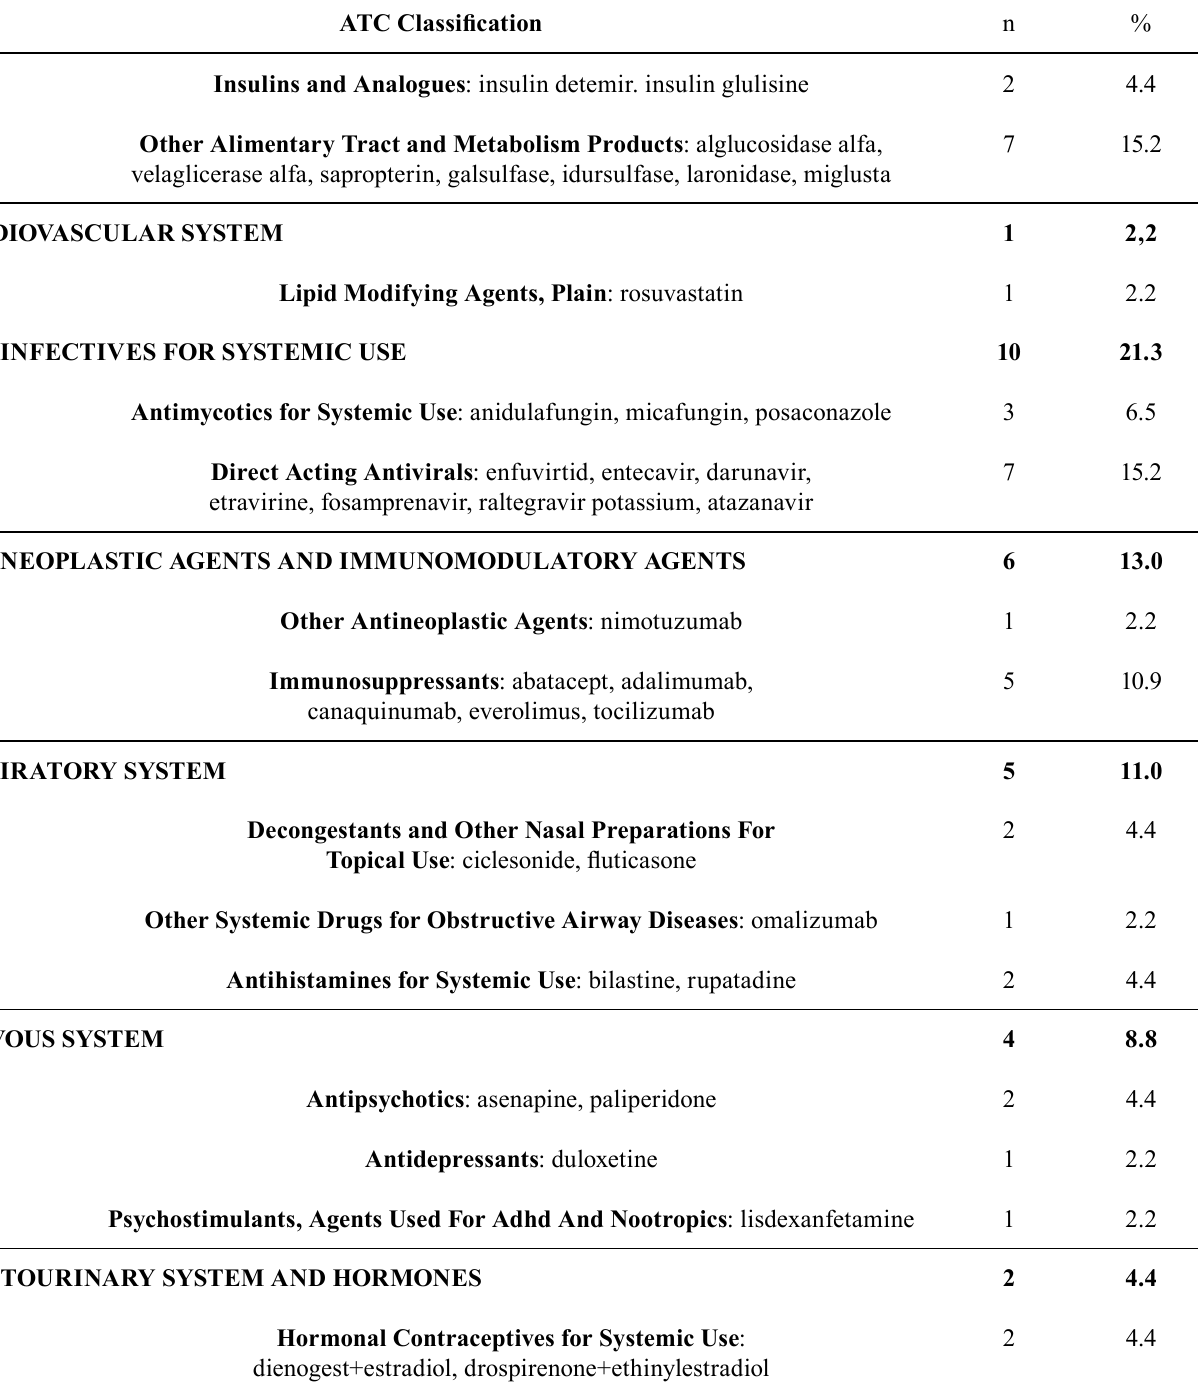
TABLE I – Anatomical Therapeutic Chemical Classification of the 46 pediatric drugs identified in the cohort of new drugs registered from 2003 to 2013